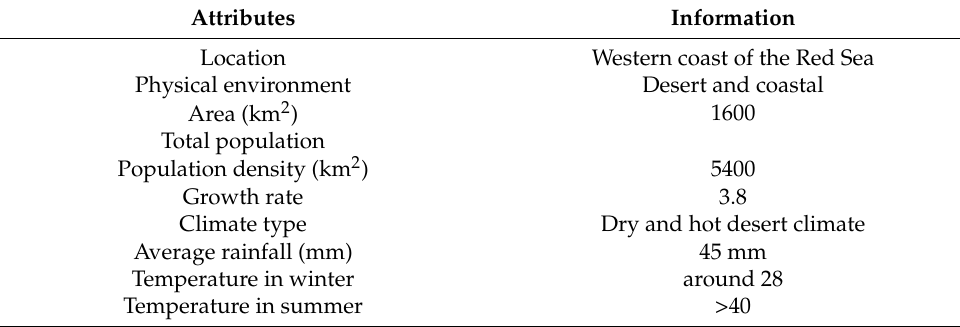
Table 1. Profile of the Jeddah city.